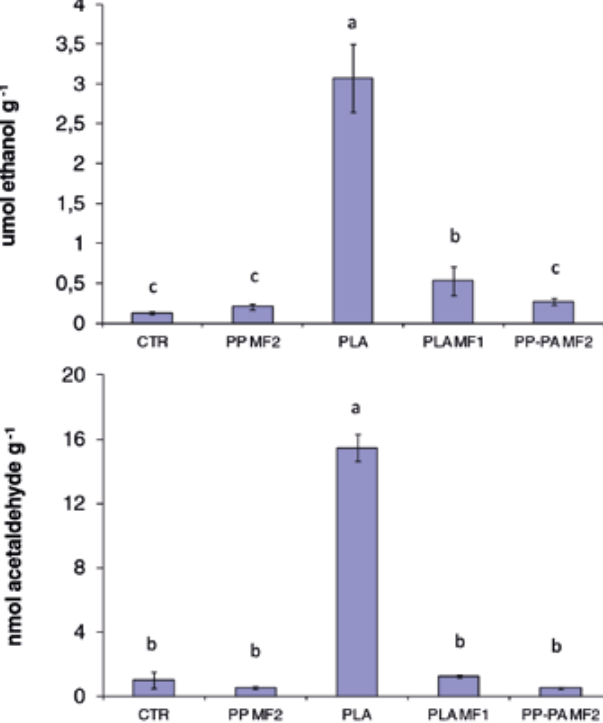
Fig. 3 - Weight loss over time of cut bract and external surfaces of fresh- cut artichoke quarters packaged in active modified atmosphere (5% O + 10% CO ) and stored at 4°C: PP+PAMF2 = poly- 2 2 propylene + polyamide with two lines of micro-perforations; PP MF2= polypropilene with two lines of micro-perforations; PLA MF1= polylactid acid with one line of micro-perforation; PLA= polylactic acid without micro-perforation. CTRL repre- sents samples stored in air in macro-perforated bags. At each storage sampling different letters indicate significant differ- ences (P<0.05).